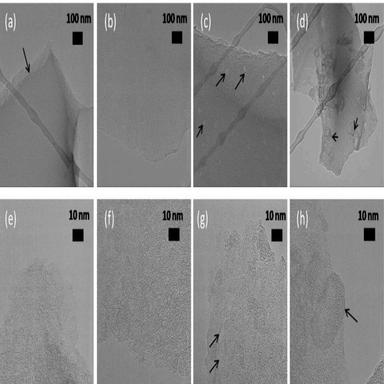
(a–d) Low-magnification and (e–h) high-magnification TEM images of AC-3.The arrow in (a) indicates the layer-like morphology, magnified in (e); thinner layer region (b) is located, which(f)on magnification, shows irregular amorphous structure; (c)arrows show the porous nature of the sample and the pores are magnified in (g); (d) some curved, spherical structure formation is indicated by arrows and magnification (h) shows its corrugated features.